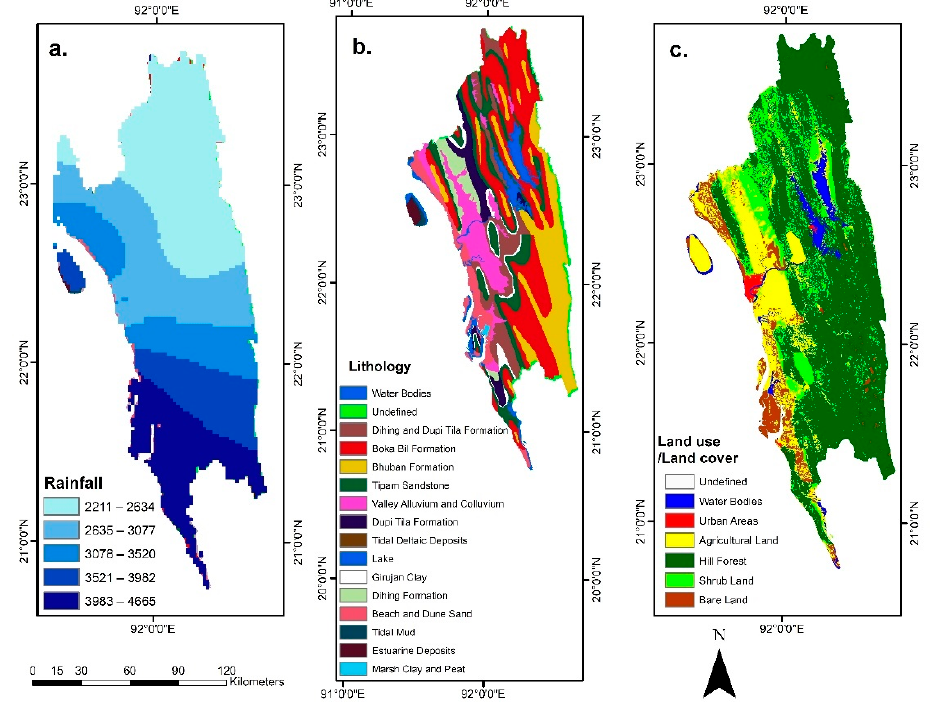
Figure 6. Predisposing Factors of Landslides. ( a ) Rainfall; ( b ) Lithology; ( c ) Land use/Land cover.